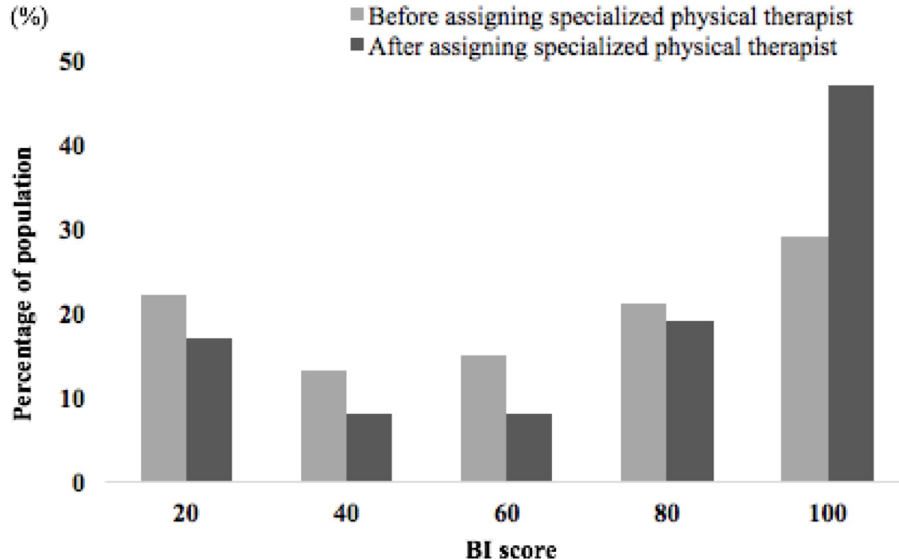
Fig 3. Distribution of patients with sepsis by BI score at hospital